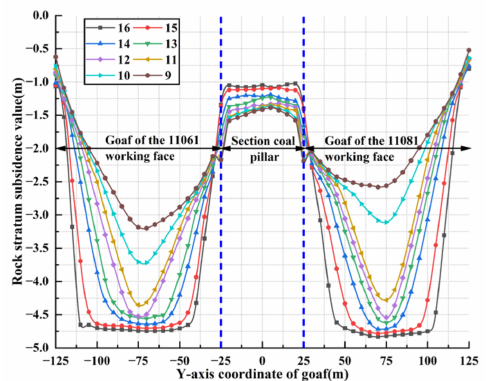
Figure 11. Subsidence values of overlying strata in the dip model of the